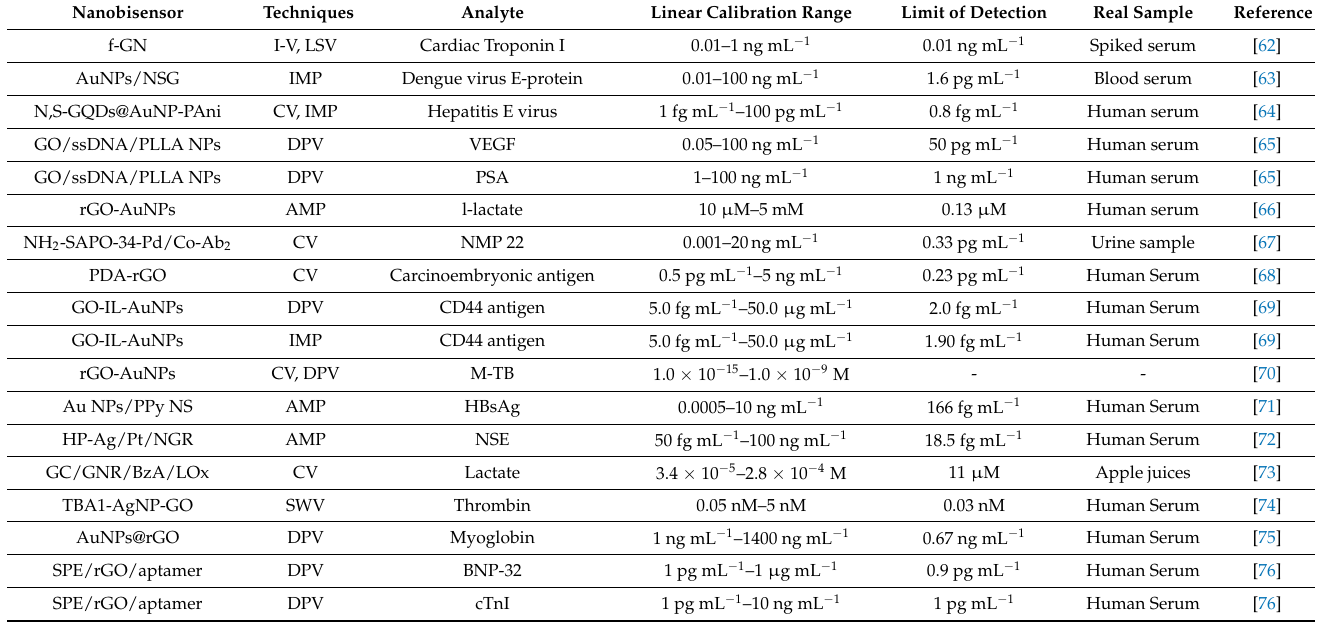
Table 2. Summary of discussed graphene-based nanobiosensors with electroanalytical